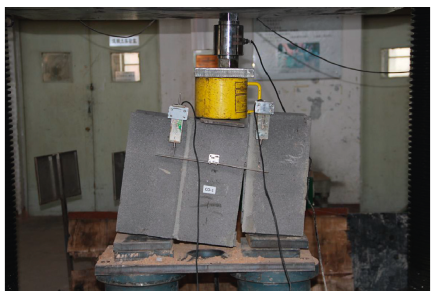
Figure 8: Typical failure modes of group CO.